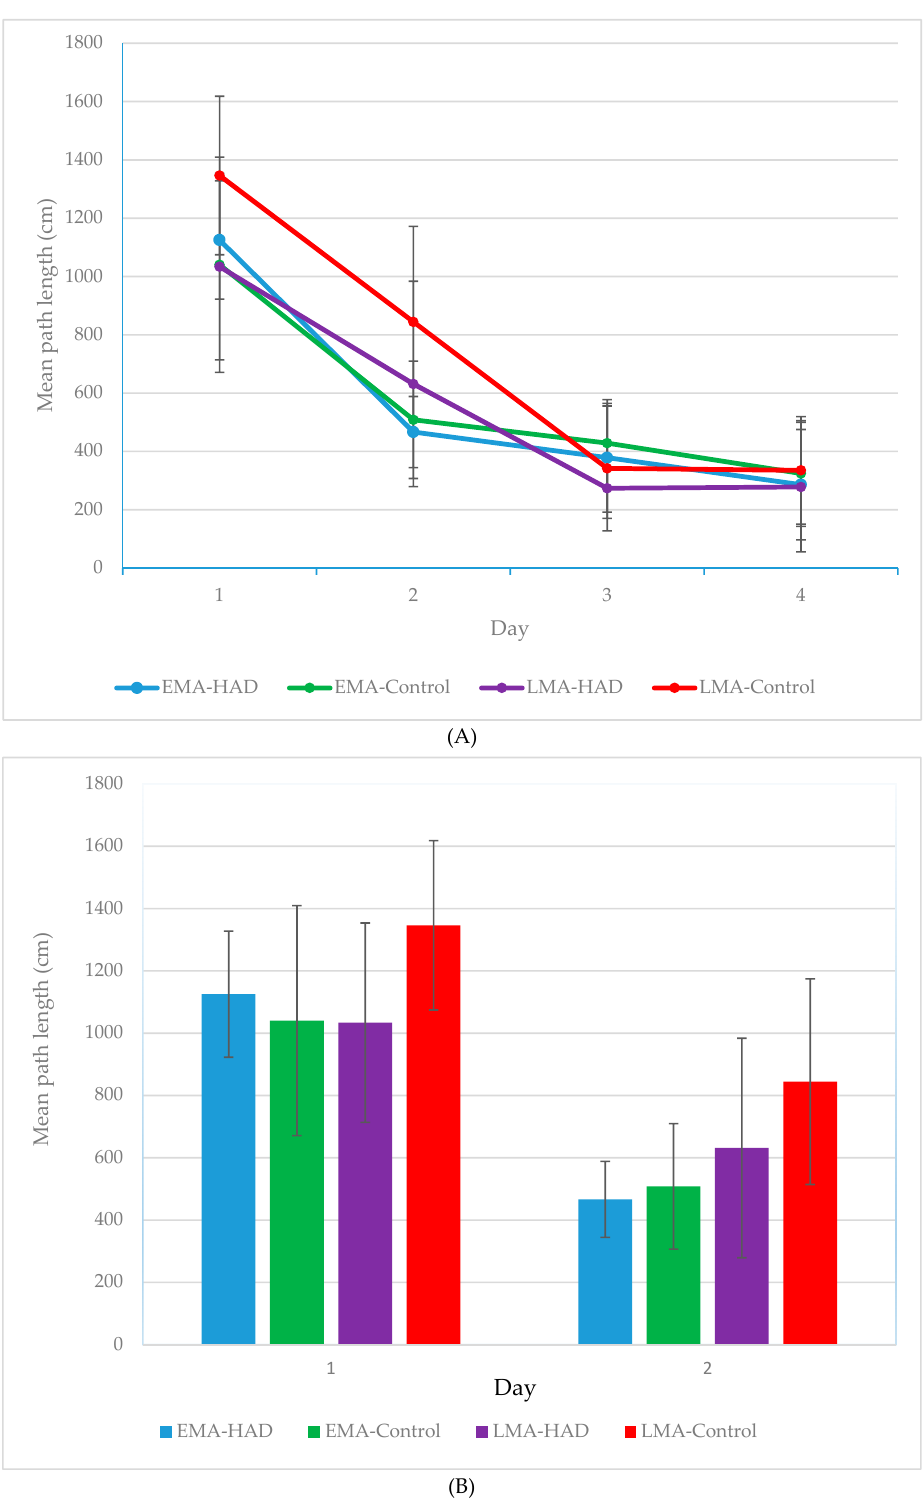
Figure 2. ( A ) Mean path length in centimeters (cm) for each condition on each training day (collapsed across the four daily trials). LMA-HAD rats performed as well on days 1 & 2 as EMA rats, whereas LMA-Controls lagged behind until day 3. Error bars represent SD. ( B ) Mean path length in centimeters (cm) for each condition on training days 1 & 2 (collapsed across the four daily trials). LMA-HAD rats performed as well on days 1 & 2 as EMA rats, whereas LMA-Controls lagged behind until day 3. Error bars represent SD.